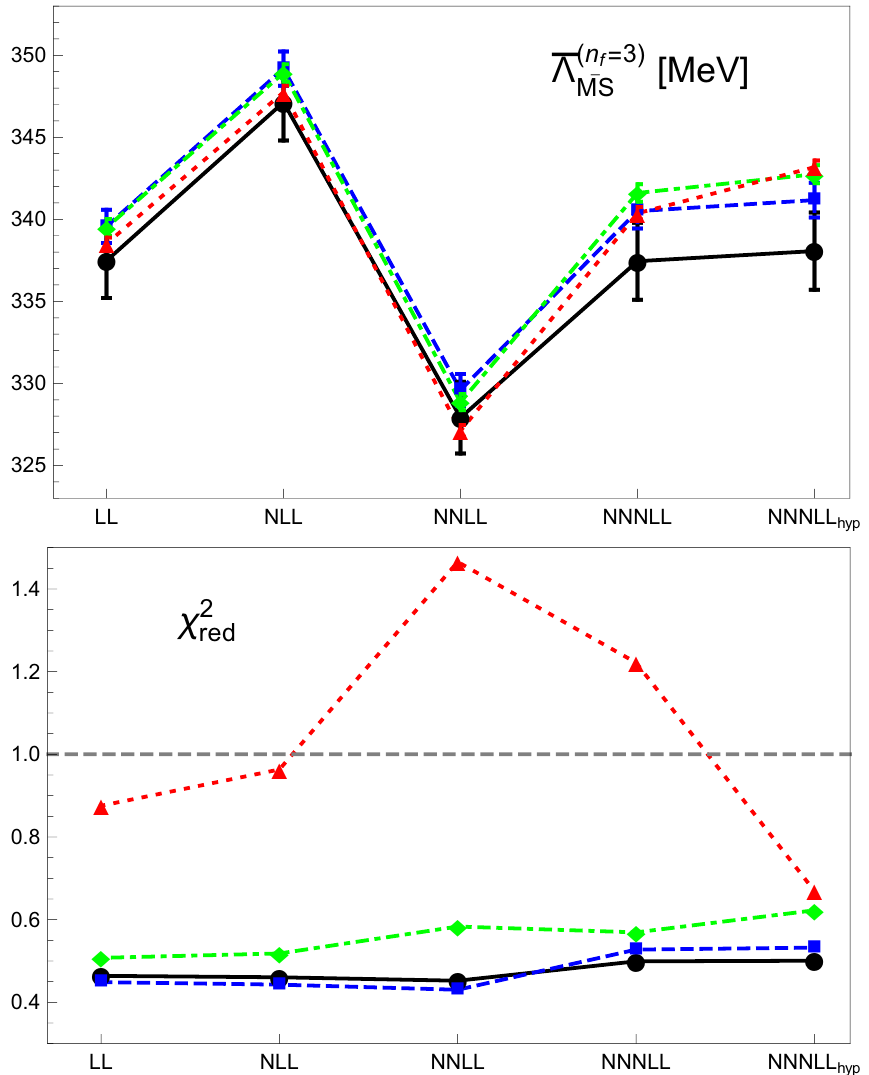
Figure 2 . Upper panel : Determination of (cid:3) ( n f =3) at LL, NLL, NNLL, NNNLL and NNNLL hyp MS using the data sets: Set I (continuous black line), Set II (dashed blue line), Set III (dash-dotted green line), and Set IV (dotted red line). The error displayed is only the statistical error of the (cid:12)ts. Lower panel : (cid:31) 2 for the (cid:12)t of (cid:3) ( n f =3) at LL, NLL, NNLL, NNNLL and NNNLL hyp using the data red MS sets (continuous black line), Set II (dashed blue line), Set III (dash-dotted green line), and Set IV (dotted red